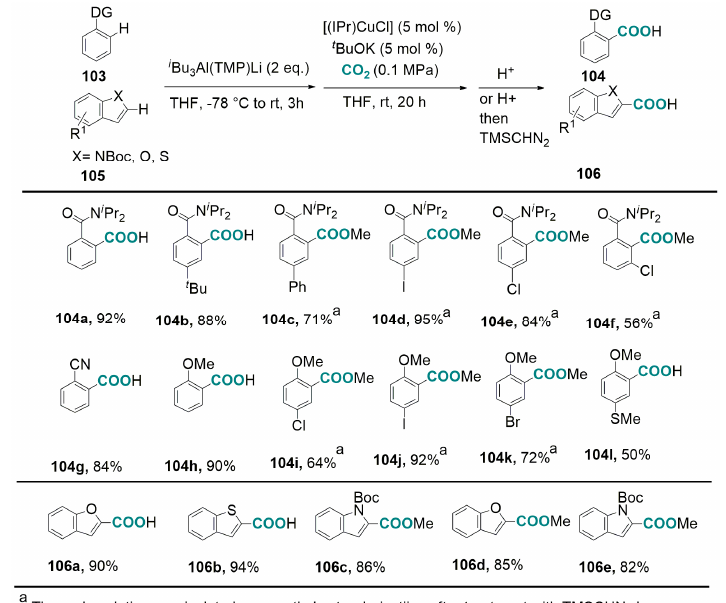
Scheme 44. Selected examples for carboxylation reactions of aromatic compounds bearing a directing group and heteroarenes by ( i Bu) 3 Al(TMP)Li base in conjunction with [(IPr)CuO t Bu] complex